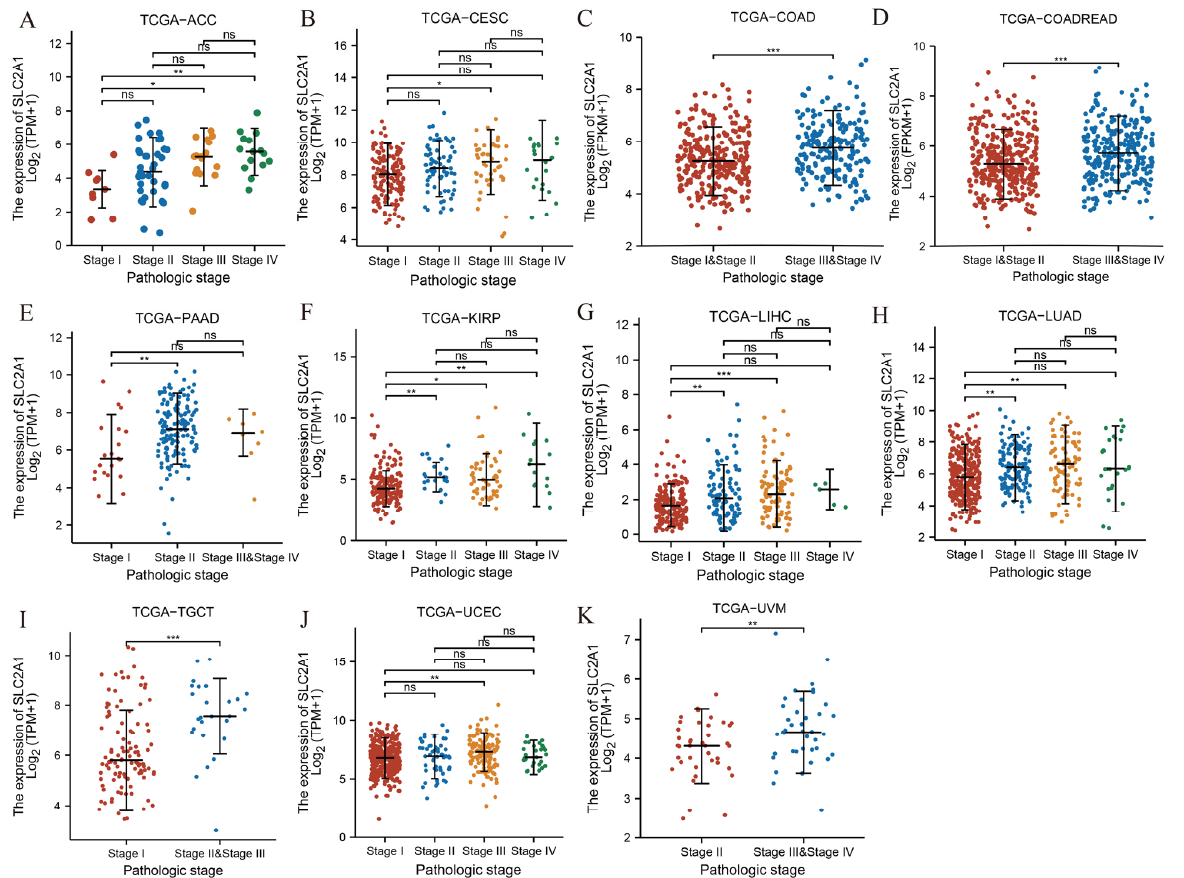
Figure 3. Pan-cancer differential expression of SLC2A1 in different pathologic stages in indicated tumor types from TCGA database ( A – K ) (ns, p ≥ 0.05; *, p < 0.05; **, p < 0.01; ***, p <